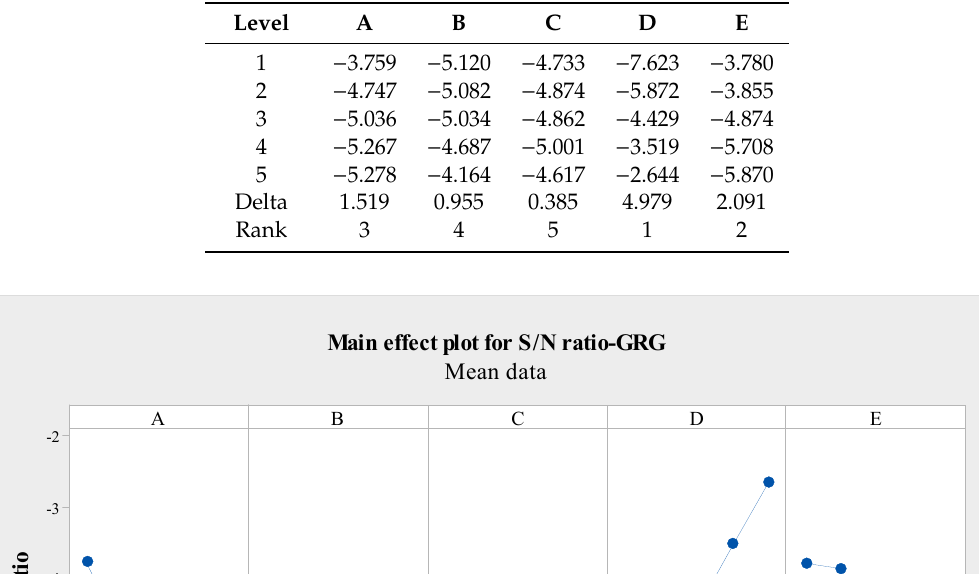
Table 13. Factorial e ff ects and weight factors for the grey relational grade.